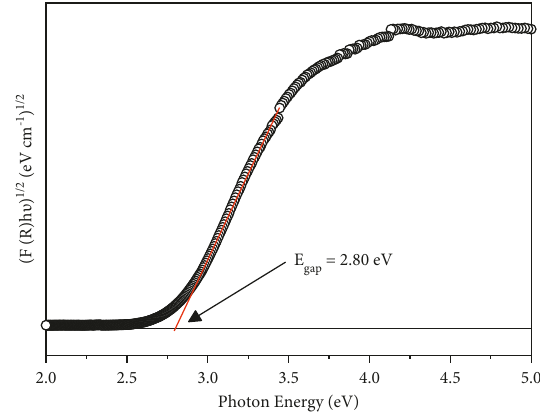
Figure 5: Diffuse reflectance ultraviolet–visible spectrum of